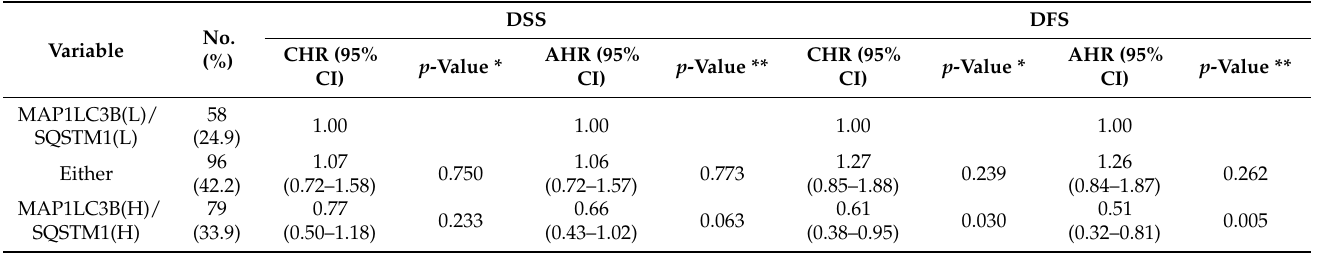
Table 4. Correlation of MAP1LC3B/SQSTM1 co-expression with survival in IDC